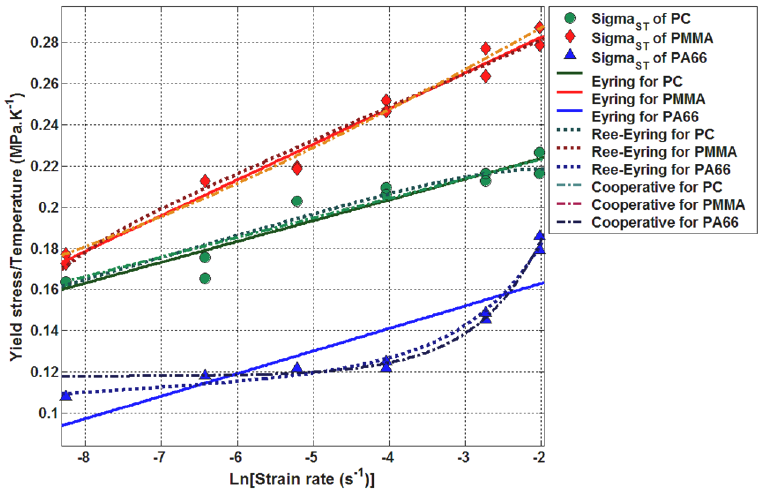
Figure 10. Evolution of the yield stress as a function of logarithm of strain rate